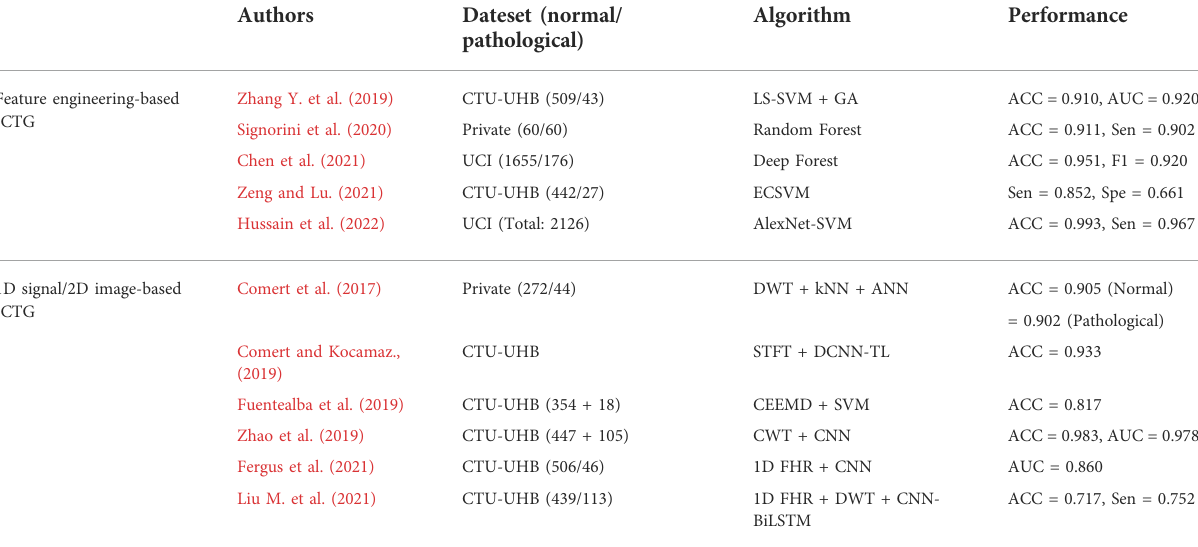
TABLE 1 A review and comparison of the existing ICTG classi fi cation models.